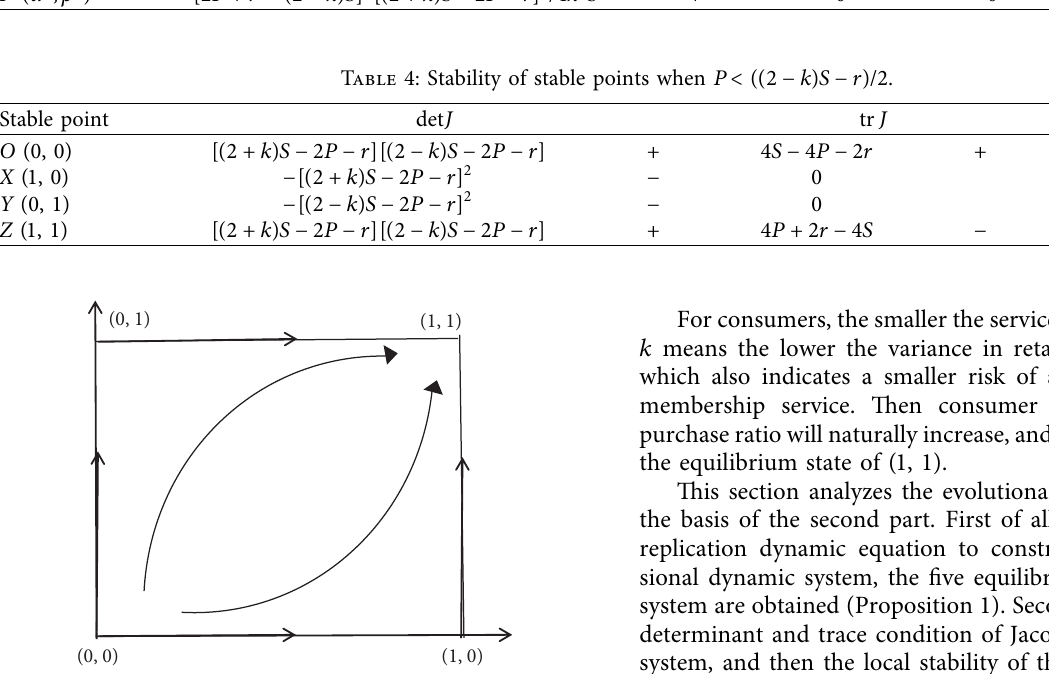
Figure 2: Dynamic diagram of evolution phase when P < (( 2 − k ) S − r )